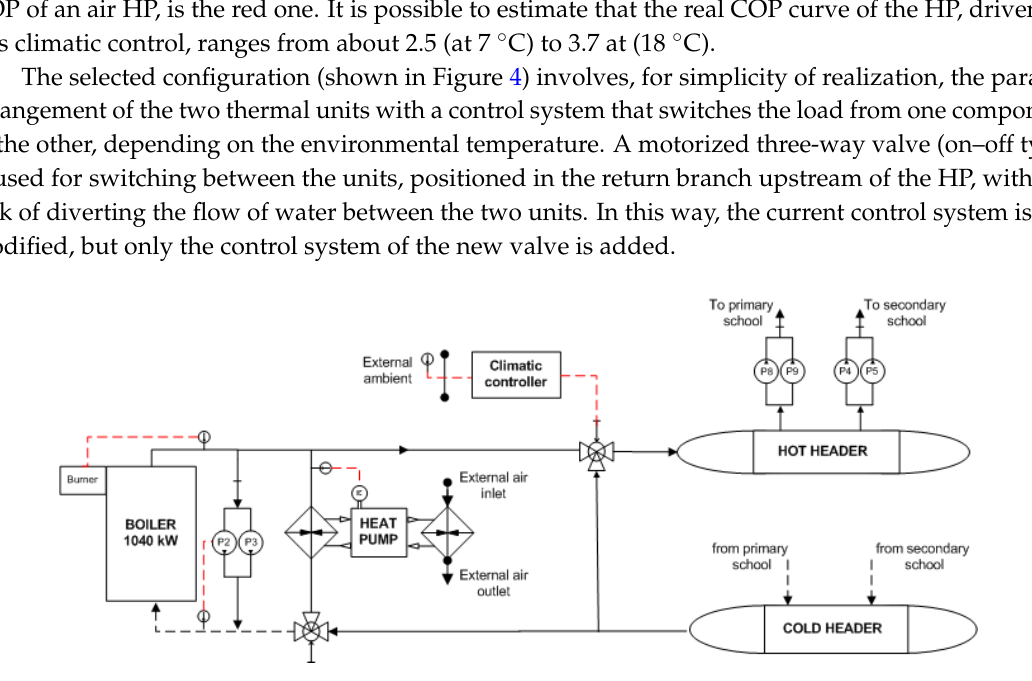
Figure 5. Building heat demand share and HDD distribution curve. In the reference year, characterized by 1606 HDD, the heat request by the school is about 352 MWh th /y, i.e., the conventional thermal plant, made by the boiler only, would require about 502 MWh NG /y equal to 50,400 Sm 3 .